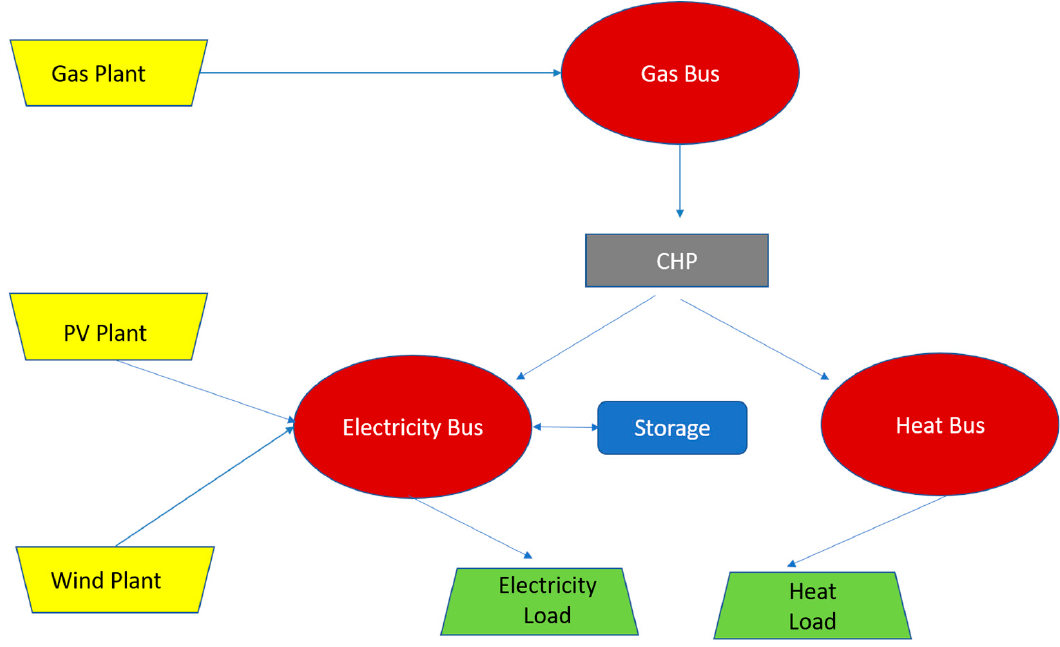
Figure 9. Exemplary energy system showing Oemof-network components. (Author’s illustration).